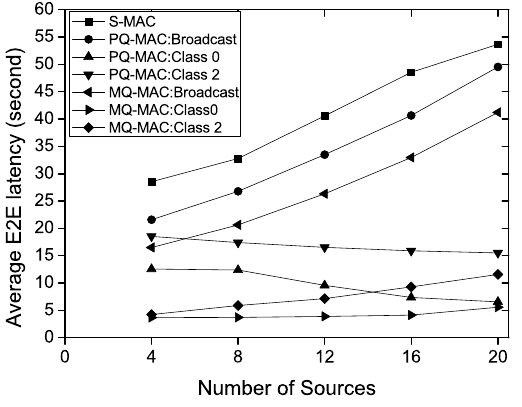
Figure 8. Average E2E latency varying number of